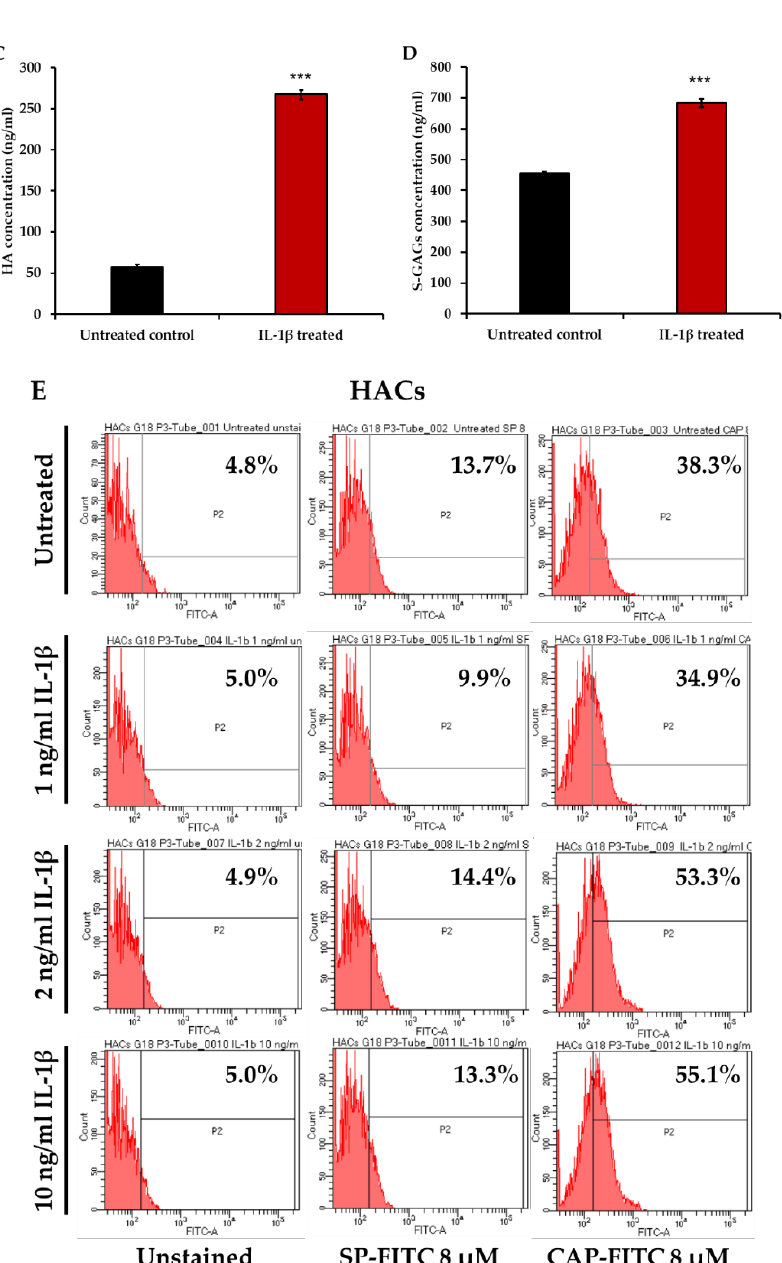
Figure 3. ( A ) Morphology of HACs in different conditions under a phase contrast microscope. The HACs at 80% confluence were maintained in serum-free DMEM for 24 h at 37 ◦ C prior to treatment with 10 ng/mL IL-1 β for 24 h. ( B ) Transcriptional expression of chondrocyte catabolic and anabolic genes in HACs by RT-qPCR ( n = 3). ( C ) ELISA analysis of HA expression in cultured medium collected from HACs ( n = 3). ( D ) ELISA analysis of S-GAGs production in the medium of HACs ( n = 3). Results are shown as mean ± SEM. ** p < 0.01, and *** p < 0.001 compared with untreated group. ( E ) Flow cytometric analysis of HACs and IL- 1β -treated HACs in various concentration at 1, 2, and 10 ng/mL. The cells were incu- bated with CAP-FITC or SP- FITC at 8 μM for 4.5 h at 37 °C. Next, the cells were washed and analyzed for FITC-positive cells.